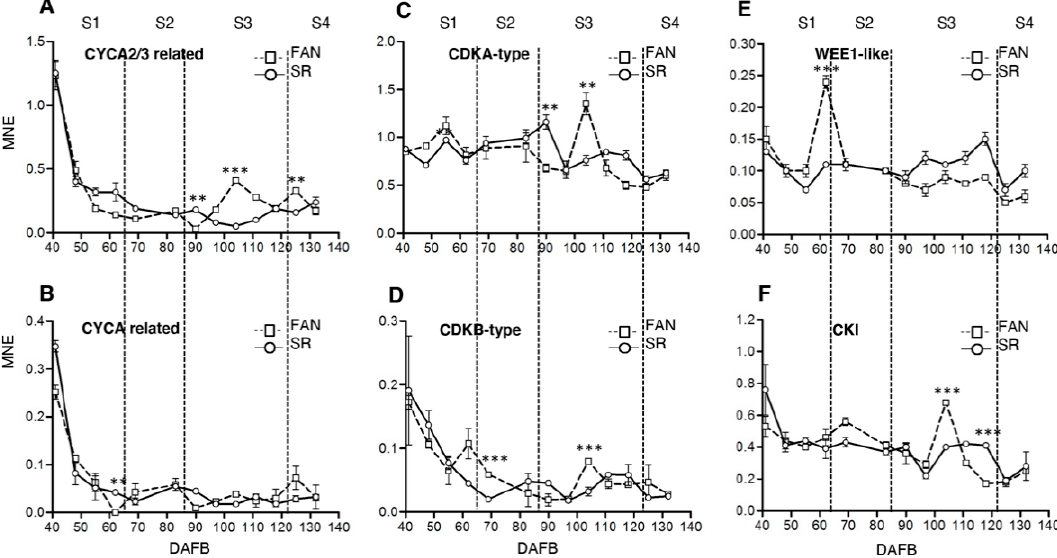
Figure 2. Expression analysis of selected target genes controlling cell cycle and endoreduplication process during the growth period of FANTASIA (FAN) and slow ripening (SR) genotype fruits. Real-time qPCR expression analysis of CYCA2/3 peach ortholog (Prupe.3G075200, Panel A ), CYCA related (Prupe.1G428100, Panel B ), CDKA-type (Prupe.2G084600, Panel C ), CDKB-type (Prupe.6G299900, Panel D ), WEE1 (Prupe.8G256300, Panel E ), and CKI (Prupe.1G006300, Panel F ) genes throughout fruit development in the mesocarp of cv FAN (square, dashed line) and SR (circle, continuous line) (for details and primers sequences see Methods). Developmental Scheme 1. S2, S3, and S4) are indicated at the top of each chart, taking FAN as a reference. Highly and extremely significant differences as determined by Student’s t test are indicated with two ( p ≤ 0.01) and three ( p ≤ 0.001) asterisks, respectively. MNE: Mean normalized expression, DAFB: Days after full bloom. Bars represent standard deviation ( n = 3).